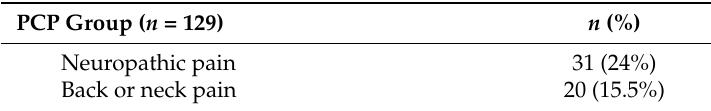
Table 1. Frequency of primary diagnoses in primary pain (PCP) and juvenile idiopathic arthritis (JIA)